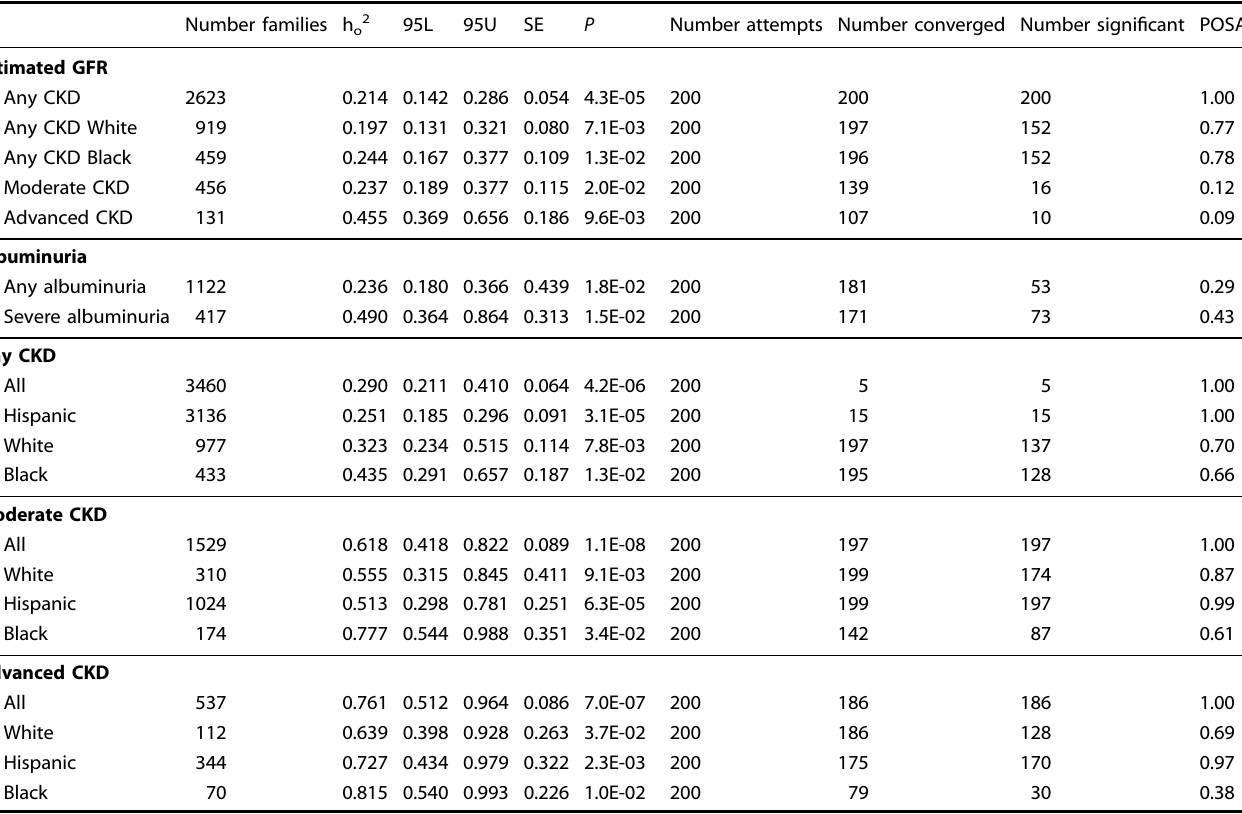
Table 3. EHR-based observational heritability (h o2 ) of eGFR, CKD, and